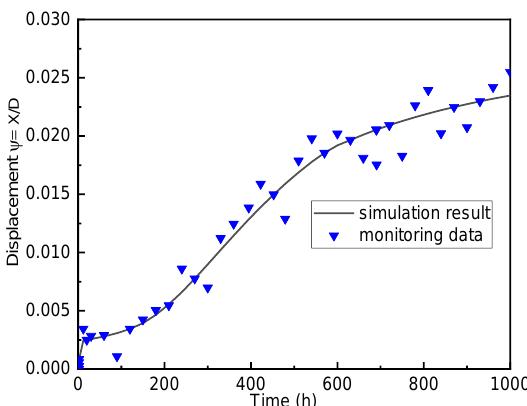
Figure 6. Validation of the model by comparing the displacement results obtained from the simulation and the on-site